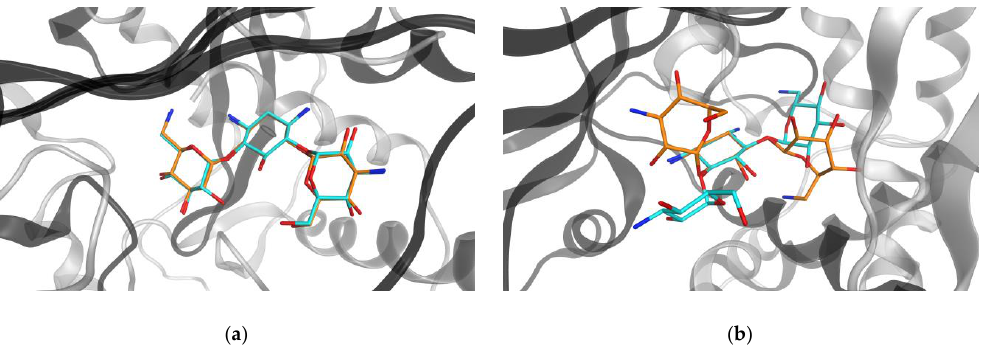
Figure 7. Kanamycin bound to different targets. Compared are binding modes of kanamycin in the active sites of ( a ) aminoglycoside 3’-phosphotransferase (gray, PDB ID: 1L8T), with ligand carbon atoms (LCs) colored in orange, and aminoglycoside acetyltransferase (black, PDB ID: 6BFH), LCs in cyan (shape similarity: 0.94), and ( b ) ribosome inactivating protein (gray, PDB ID: 3U6T), LCs in orange, and 2’’-aminoglycoside nucleotidyltransferase (black, PDB ID: 4WQL), LCs in cyan (shape similarity: 0.61).